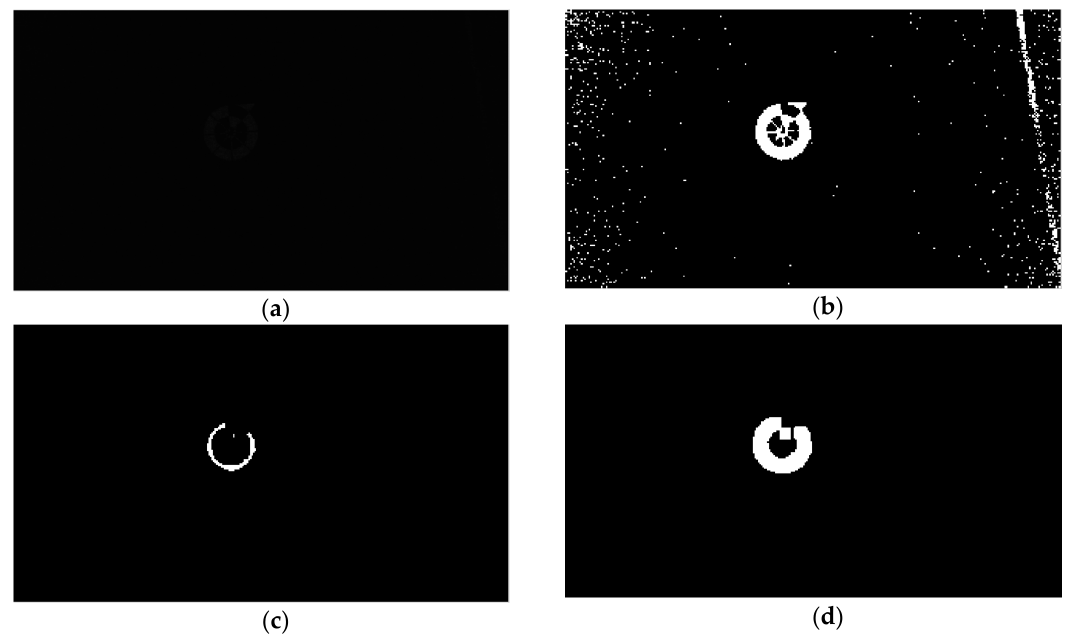
Figure 9. Our proposed marker segmentation results: ( a ) original image; ( b ) after applying adaptive thresholding; ( c ) after applying Hit and Miss morphology ( d ) final result after dilation.